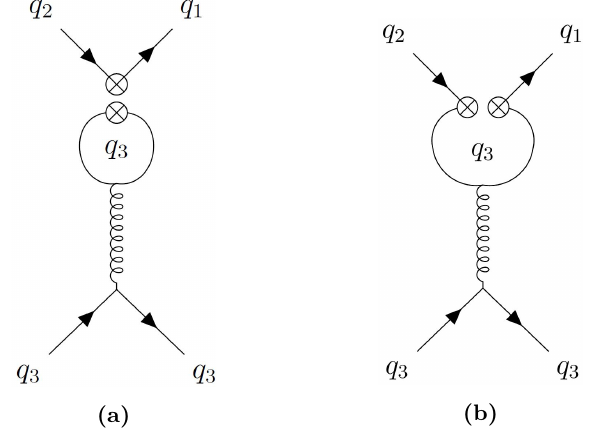
Figure 3. QCD penguin diagrams for four-quark